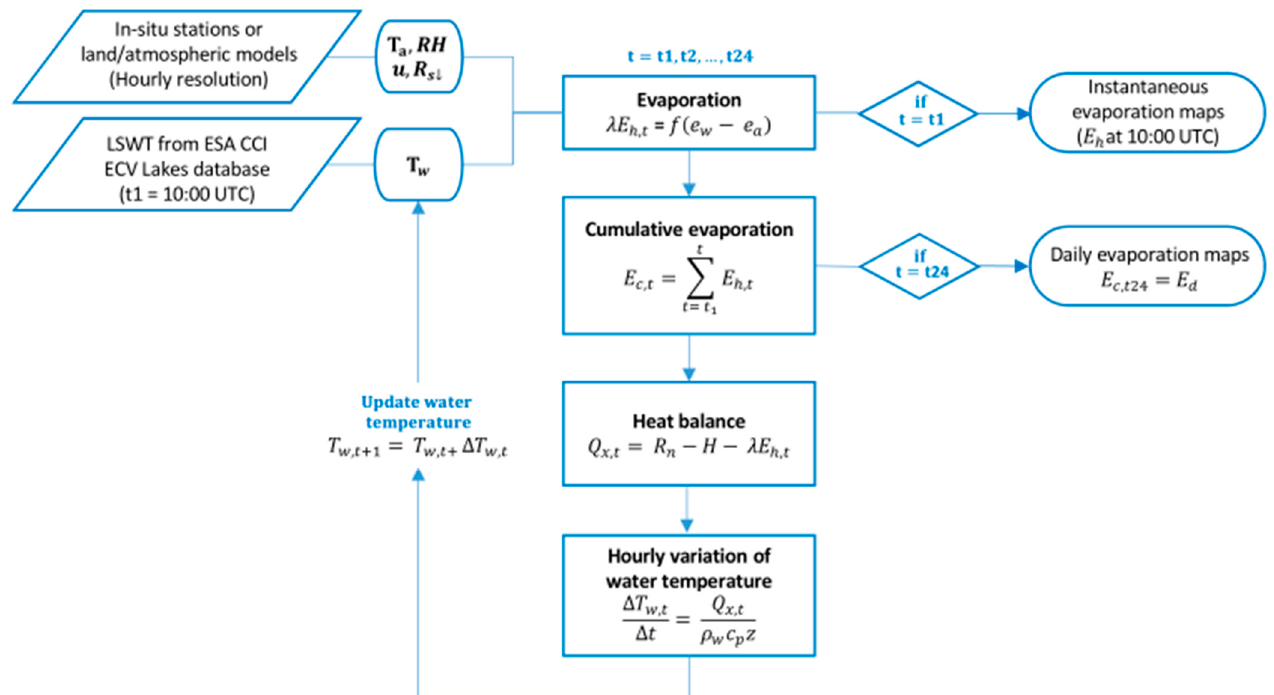
Figure 2. Workflow for the generation of evaporation products from LSWT maps.